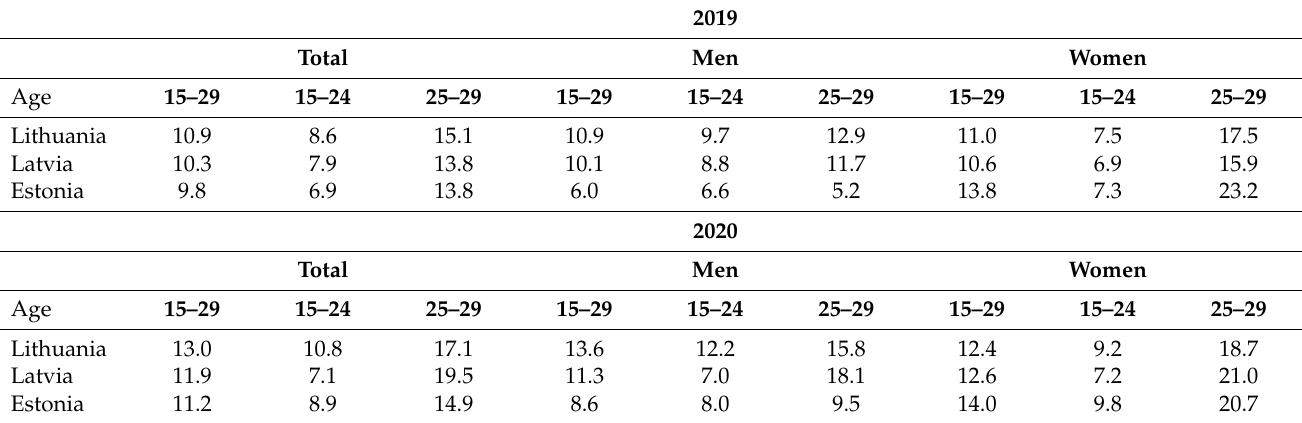
Table 1. NEET youth statistics in the Baltic countries, 2019–2020. Source: Eurostat